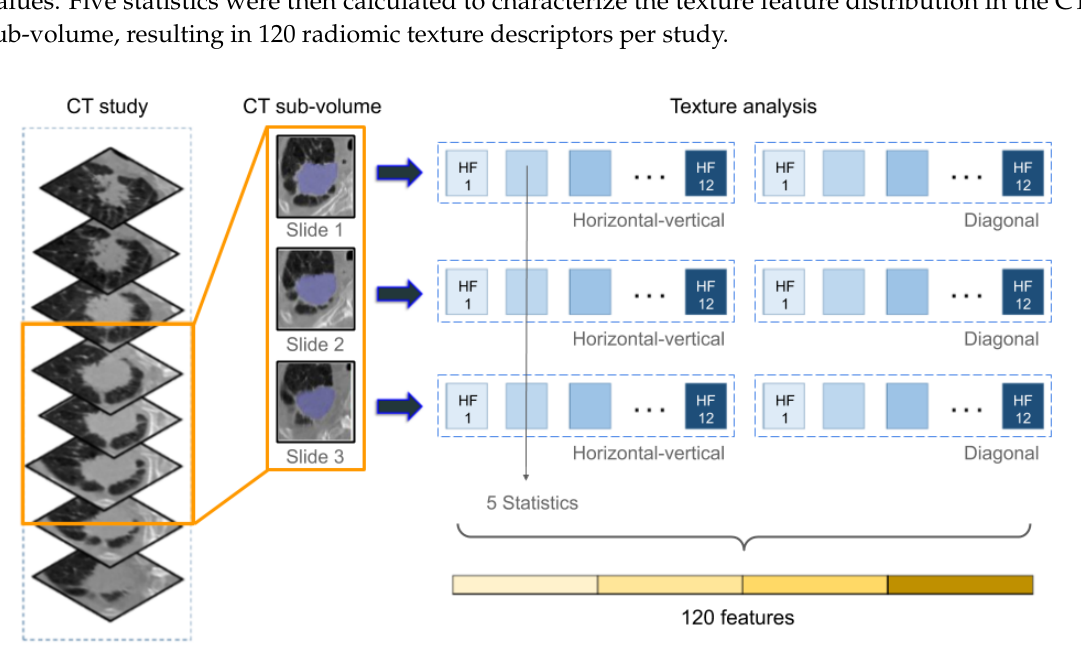
Figure 3. Texture analysis in CT to compute radiomic features: For each CT study, a sub-volume is defined as the largest annotated 2D section of the tumor together with two adjacent slices. For each sub-volume, co-occurrence matrices are computed based on CT image intensity values, based on which 12 Haralick features (HF) are calculated. Finally, five statistics are computed per Haralick feature to yield 120 radiomic